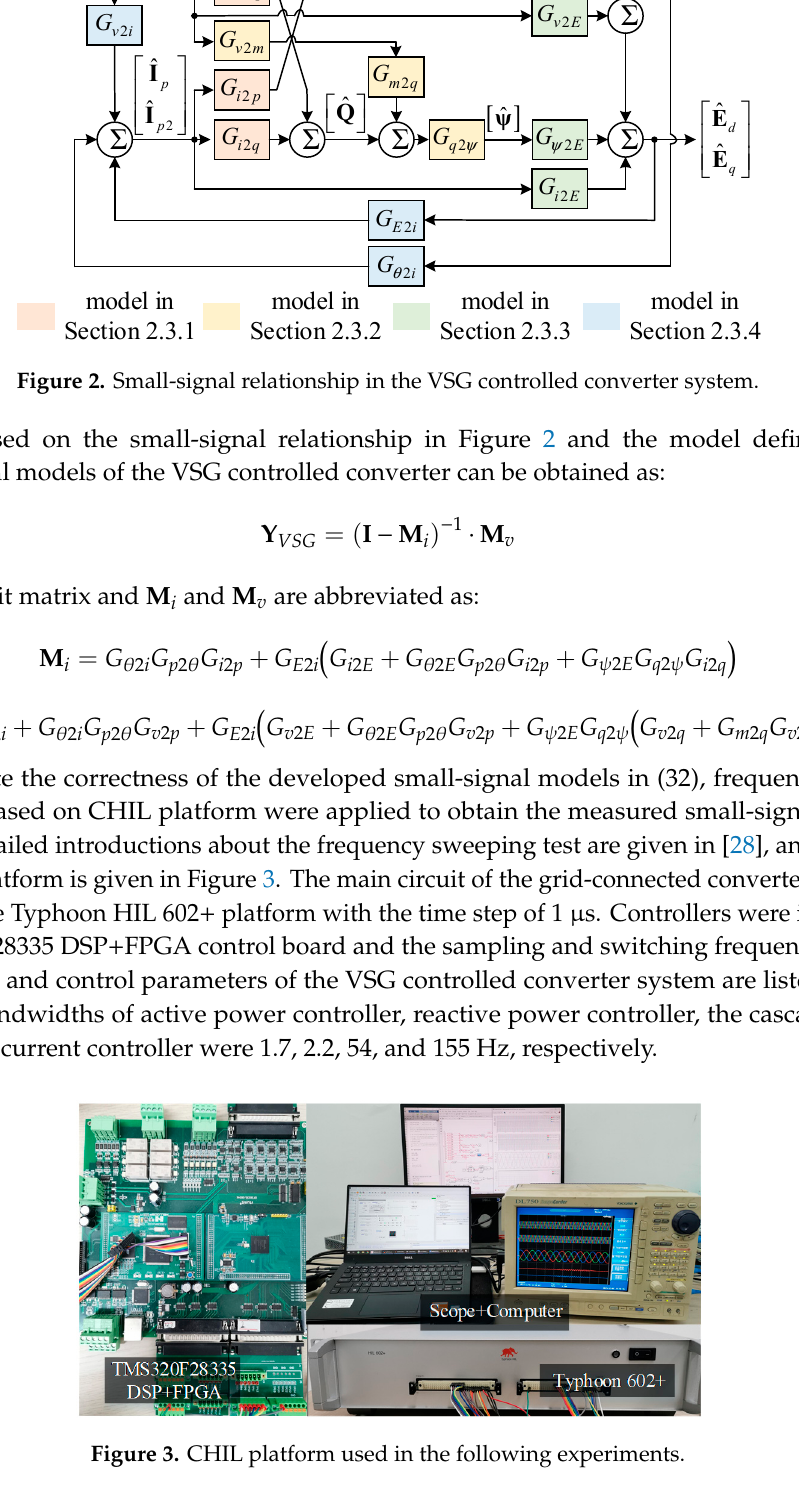
Figure 3. CHIL platform used in the following experiments. Table 1. Parameters of VSG controlled converter system.